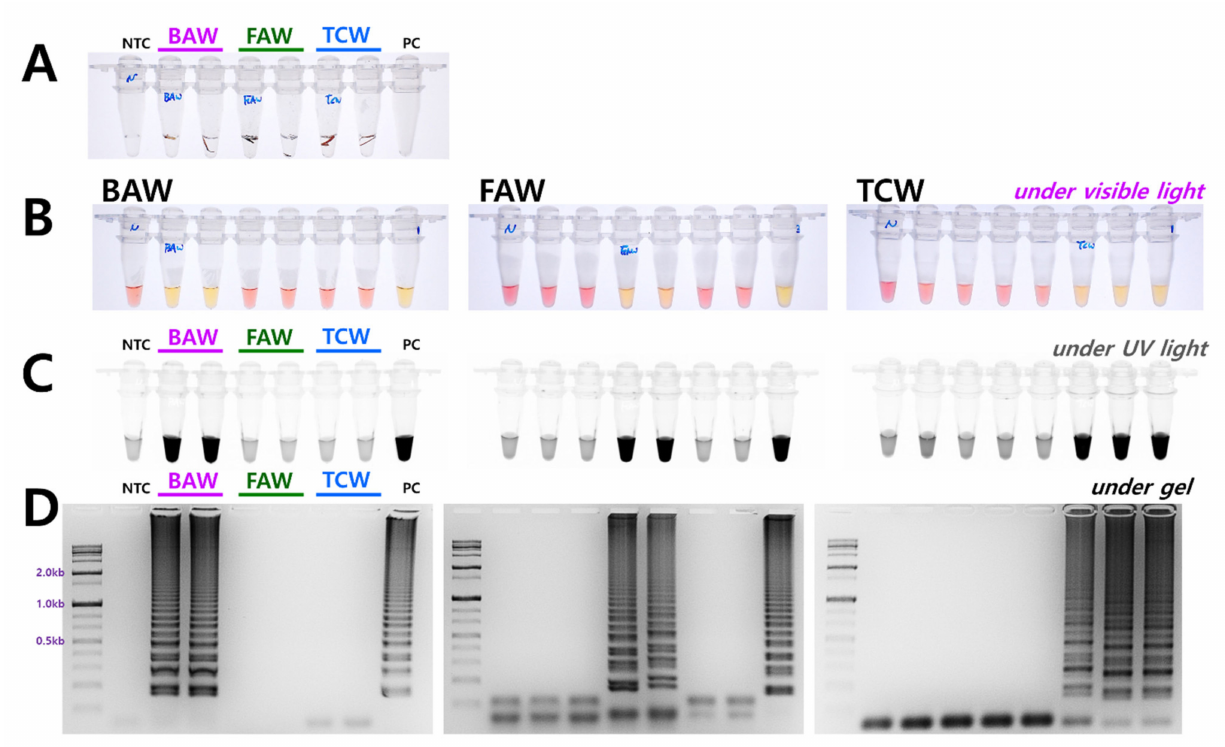
Figure 4. Representative LAMP assay results with the DNA release technique from ( A ) insect tissue. Around 10 mg of larval tissue or adult leg (or antenna) was incubated at 95 ◦ C for 5 min. LAMP assay results with four primers (F3, B3, FIP, and BIP) ( B ) under visible light, ( C ) ultraviolet light with SYBR Green, and ( D ) gel electrophoresis. The tubes in panel B and C and vertical lines in panel D have the same order of the species of DNA. NTC: no template control, PC: positive